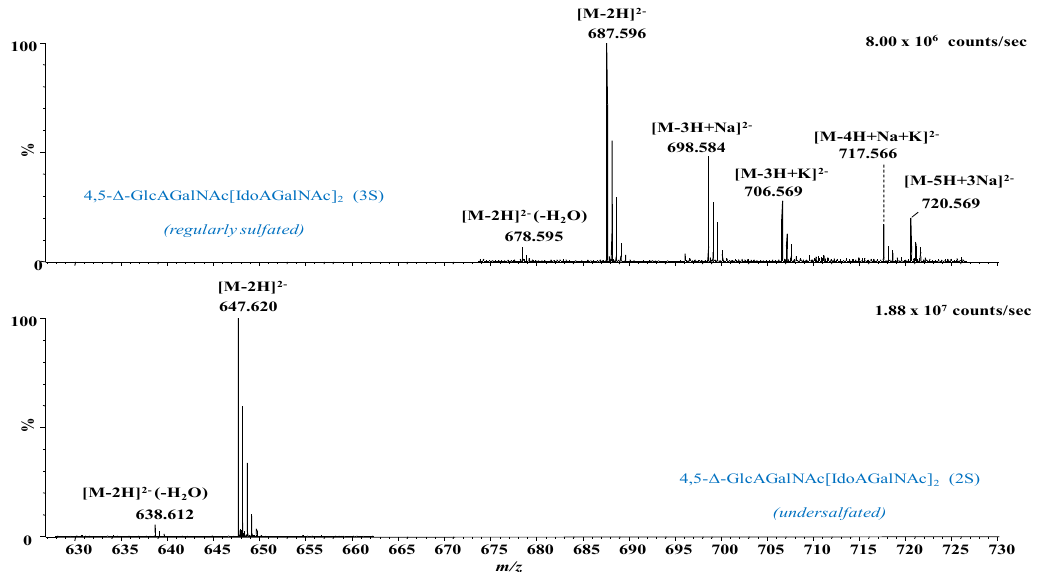
Figure 3. Extracted (-) nanoESI IMS mass spectra of doubly charged di- and trisulfated 4,5- Δ -GlcAGalNAc[IdoAGalNAc] 2 from the corresponding areas indicated in Figure 2. n S-number of SO 3 groups.